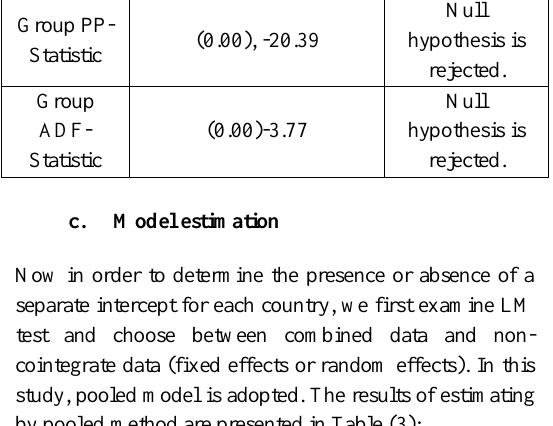
Table 3: Estimation results Variable